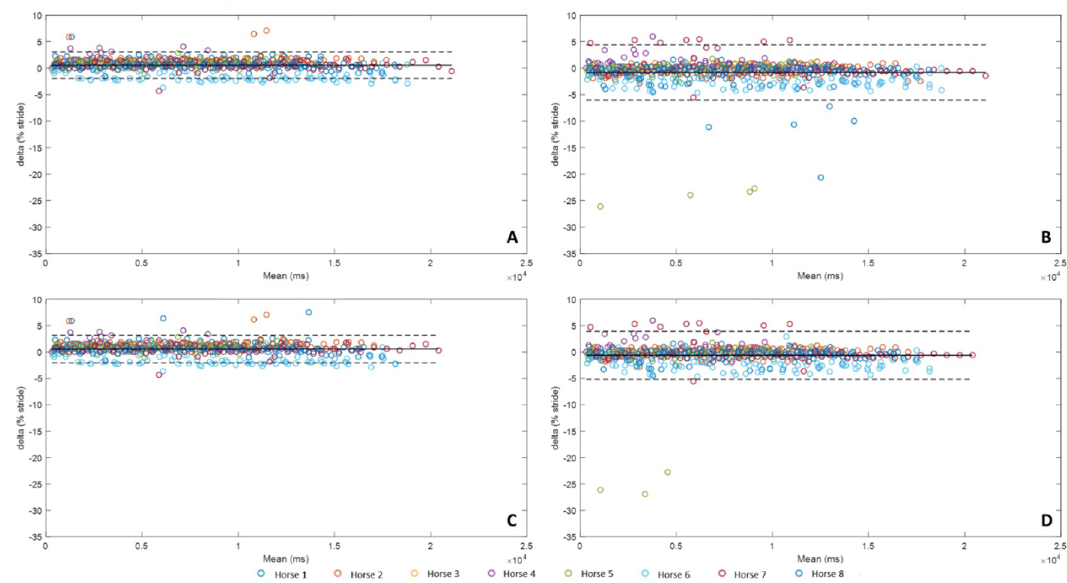
Figure 5. Bland-Altman comparison of the Foot on detection of the four methods developed with IMU data and MoCap Foot on detection. Accuracy (bias between each method and MoCap) and limits of agreement (95% limits of agreement) of method A were represented on the upper left corner ( A ), method B on the upper right corner ( B ), method C on the lower left corner ( C ), and method D on the lower right corner ( D ).